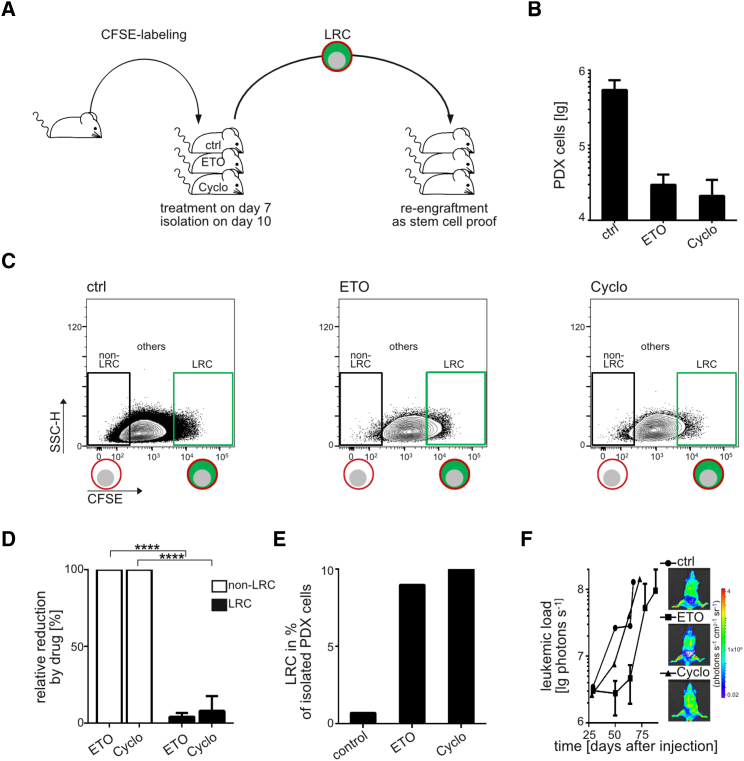
LRC Survive Systemic Drug Treatment In Vivo(A) Each mouse was injected with 107 CFSE-stained ALL-265 PDX cells and treated with buffer, etoposide (ETO, 50 mg/kg, intraperitoneally [i.p.]), or cyclophosphamide (Cyclo, 150 mg/kg, i.p.) on day 7. Mice were euthanized on day 10; LRC were analyzed and re-transplanted into secondary recipients.(B) Living PDX cells from mice in (A) were quantified and presented as mean of each group (n = 4–5) ± SE.(C) Original data for one representative mouse per treatment.(D) Mean of all four to five mice per treatment, depicted as relative drug effect on LRC compared with non-LRC (100%) ± SE; ∗∗∗∗p < 0.0001 by two-tailed unpaired t test.(E) Mean relative proportion of LRC of total PDX cells.(F) LRC isolated were re-transplanted and mice monitored by in vivo imaging; mean of each group (n = 1–2) ± SE.See also Figure S4.